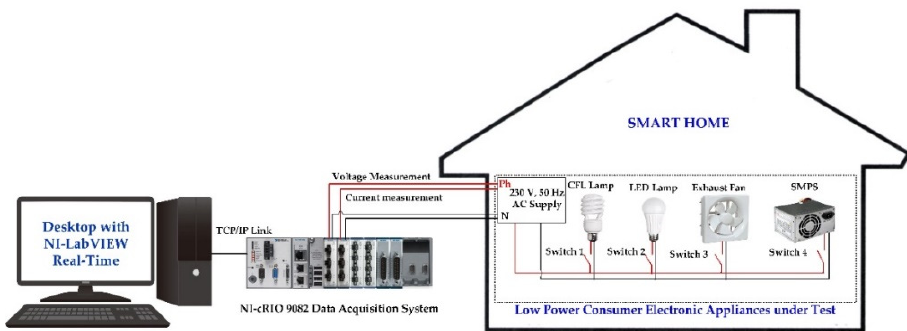
Figure 3. Hardware/lab setup for the measurement of the TPF.